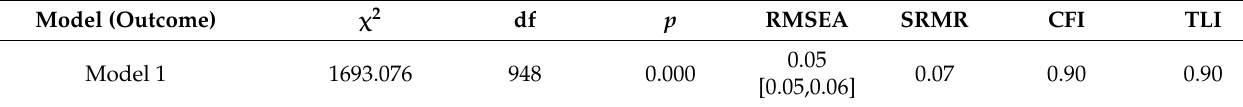
Table 3. Fit indices and standardized direct and indirect effects for the mediation